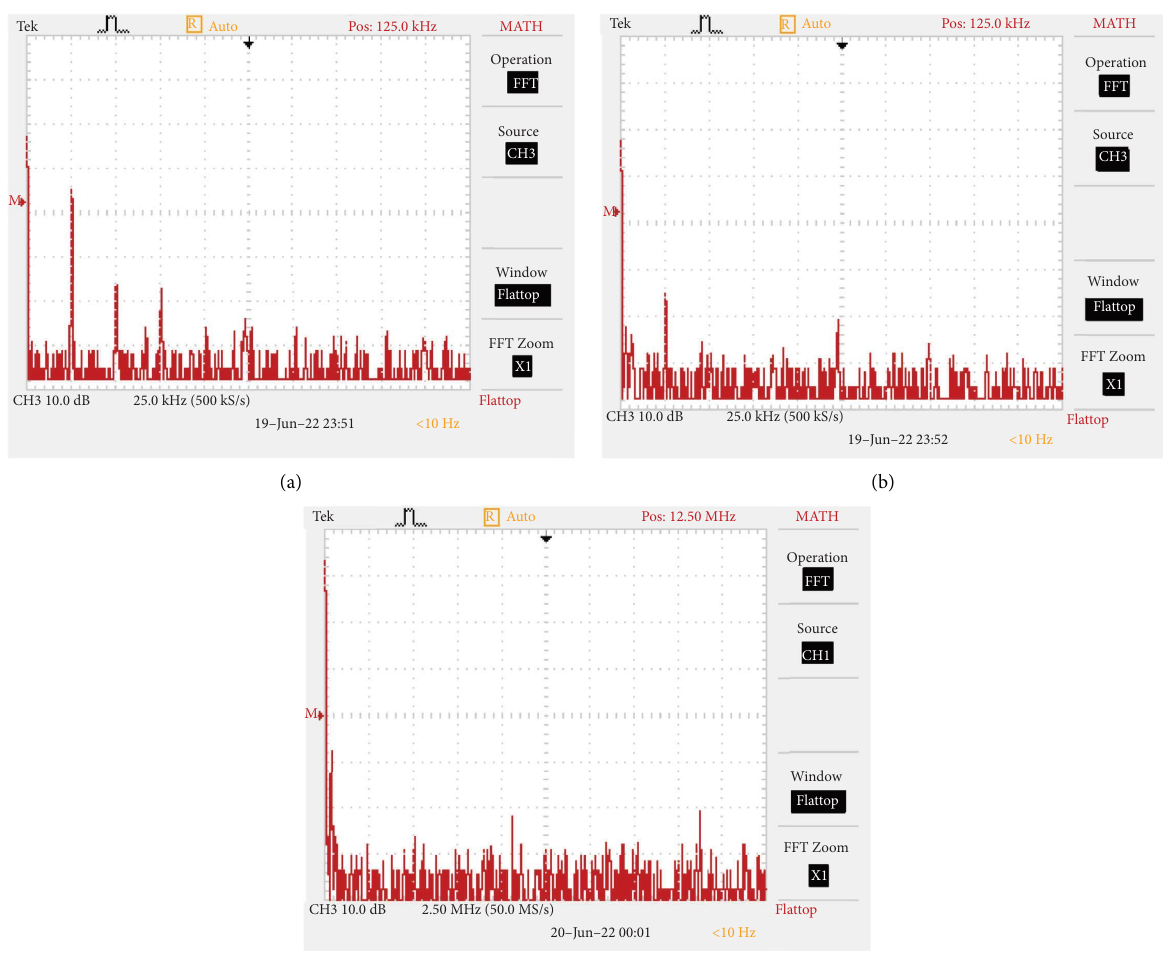
Figure 21: (a) I L 1 at 25kHz, (b) I in at 25kHz, and (c) I in at 2.5 MHz with LCL